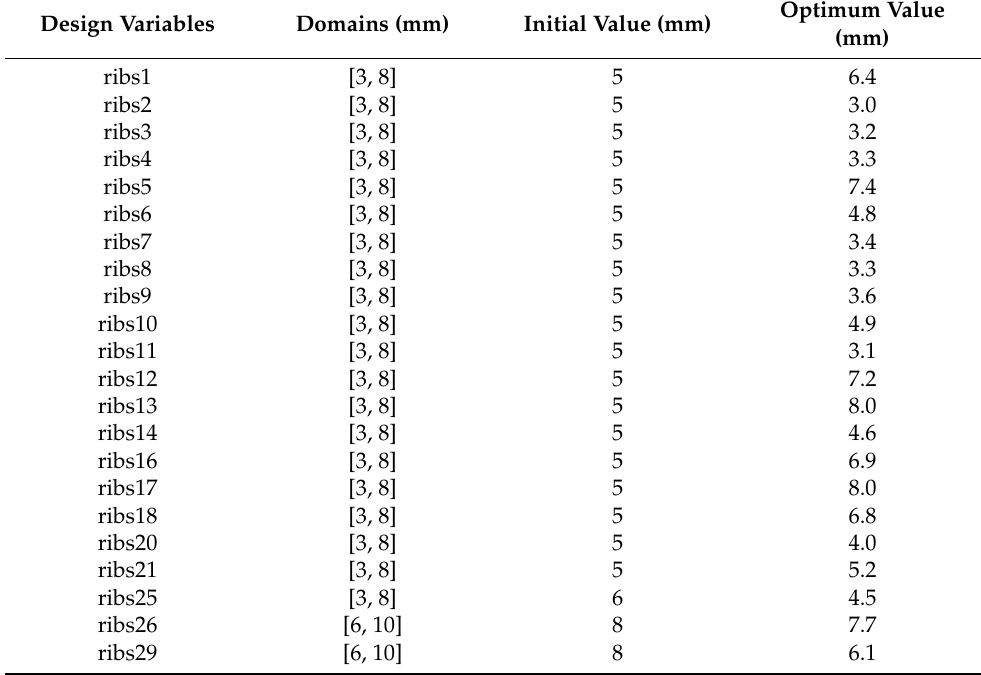
Table 3. Optimal thicknesses of the lightweight